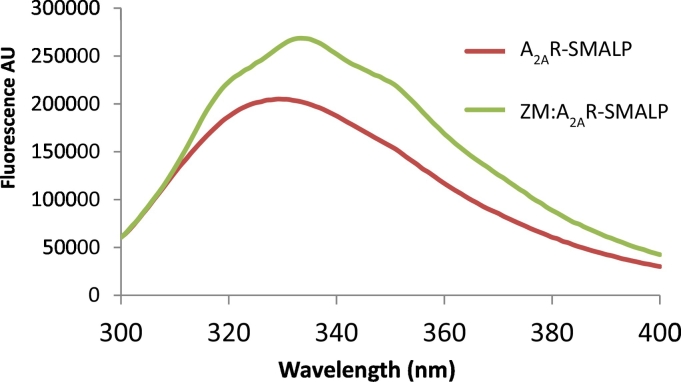
Fluorescence of A2AR-SMALP.Fluorescence spectrum in the absence (A2AR-SMALP) and presence (ZM:A2AR-SMALP) of ZM241385 (1 μM).